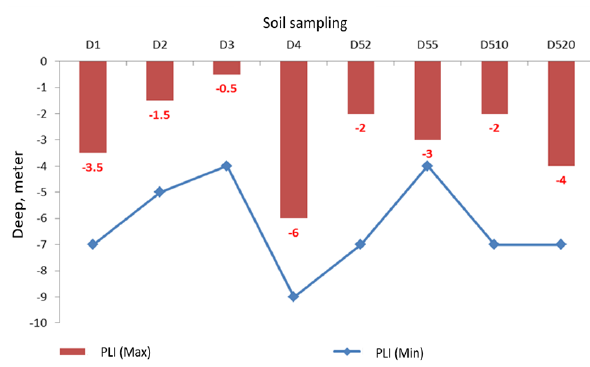
Figure 3. Vertical (Deep in pit latrines) distribution of soil microbial contamination in ger areas